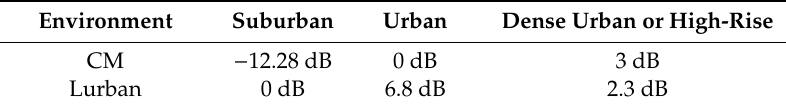
Table 2. Parameters’ value of C M and L